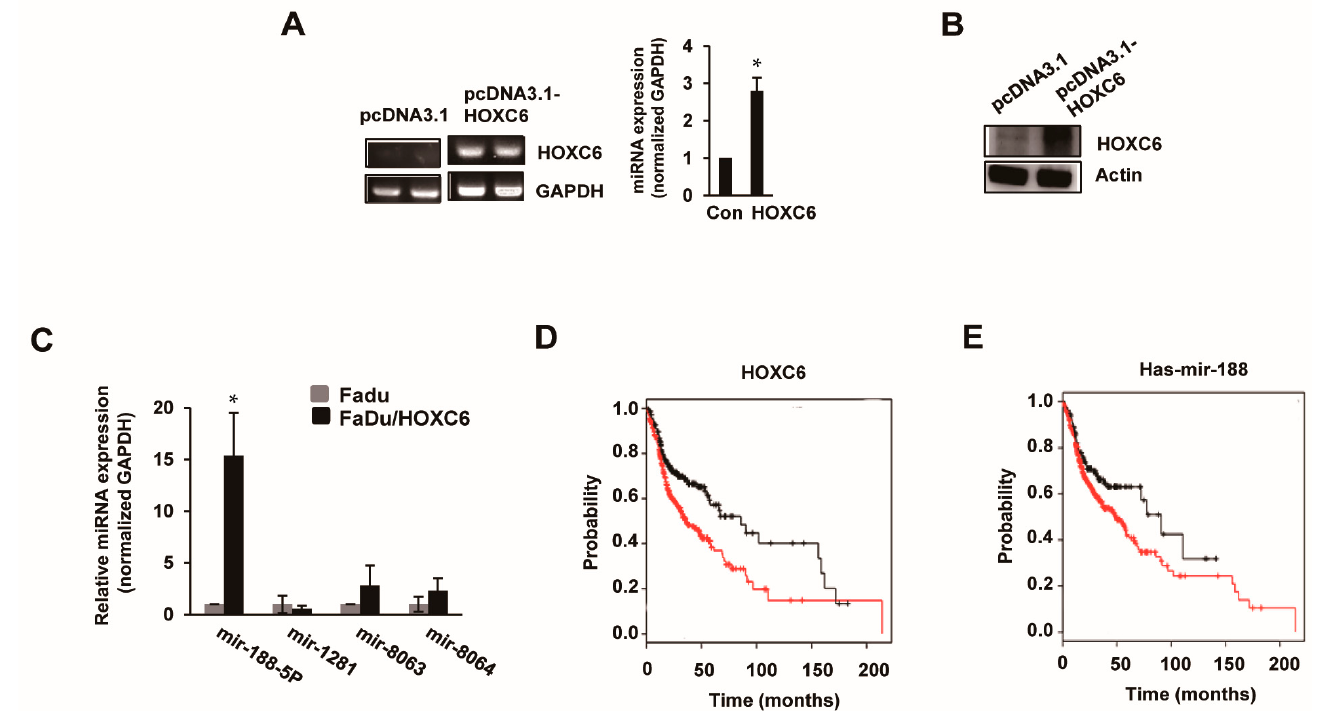
Figure 2. Validation of identified miRNAs using quantitative reverse transcription polymerase chain reaction (qRT-PCR). Total RNA was isolated from HOXC6-overexpressing FaDu cells. ( A , B ) FaDu cells were transfected with pcDNA3-HOXC6. Forty-eight hours after transfection, the cells were collected to measure HOXC6 gene and protein expression. ( C ) Expression of selected miRNAs (miR-188-5p, miR-1281, miR-8063, and miR-8064) analyzed by qRT-PCR in FaDu/HOXC6 cells, and U6 was used for normalization. ( D , E ) Kaplan–Meier curves showing overall survival based on HOXC6 or miR-188-5p levels. Glyceraldehyde-3-phosphate dehydrogenase (GAPDH) was used as a loading control for RT-PCR. Relative HOXC6 mRNA expression was determined by qRT-PCR, using GAPDH as an internal control. β -actin was used as loading control for Western blot. MicroRNA expression was determined by qRT-PCR, with U6 spliceosomal RNA (U6 snRNA) serving as an internal control. The data are presented the mean ± SD of three replicates. * p < 0.05.